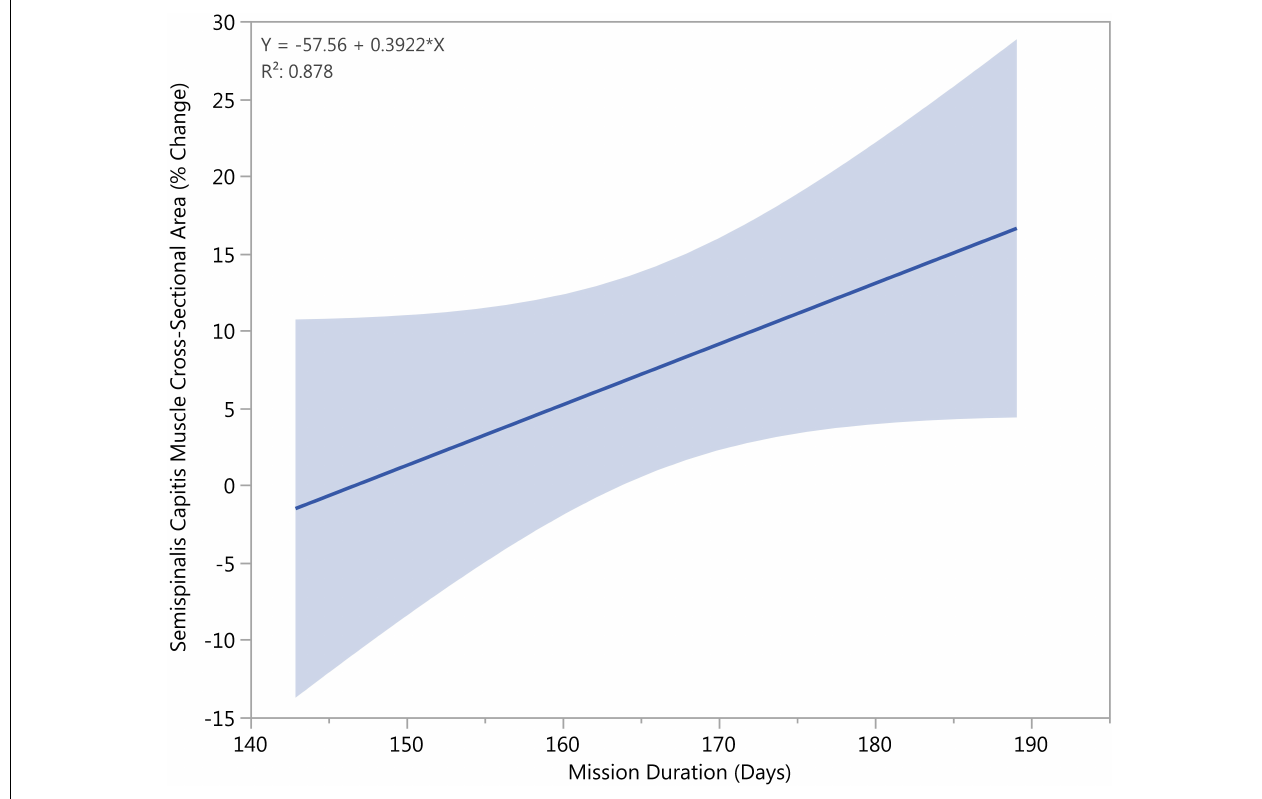
FIGURE 6 | Longer mission durations correlated with increased growth of the semispinalis capitis CSA ( p <